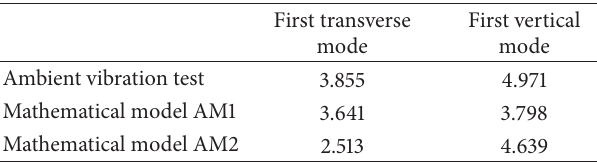
Table 4: Experimentally and mathematically identified modal frequencies